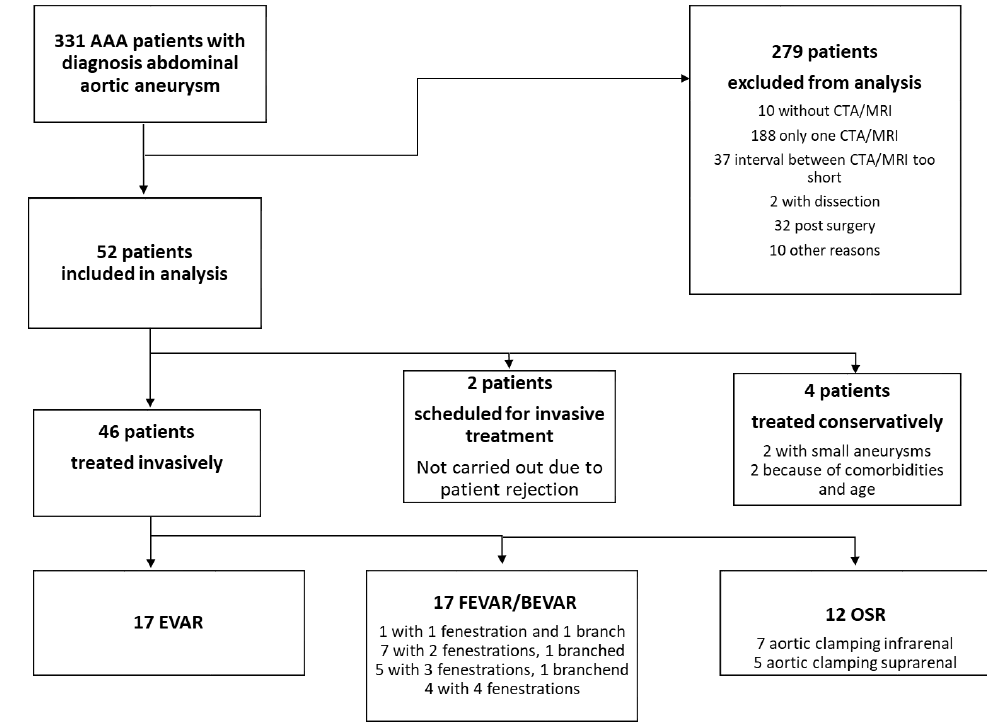
Figure 2. Flow chart showing the inclusion/exclusion of patients in the present study. AAA: abdominal aortic aneurysm, EVAR: endovascular aortic repair, FEVAR: fenestrated EVAR, BEVAR: branched EVAR, OSR: open surgery, CTA: computed tomography angiography, MRI: magnetic resonance imaging